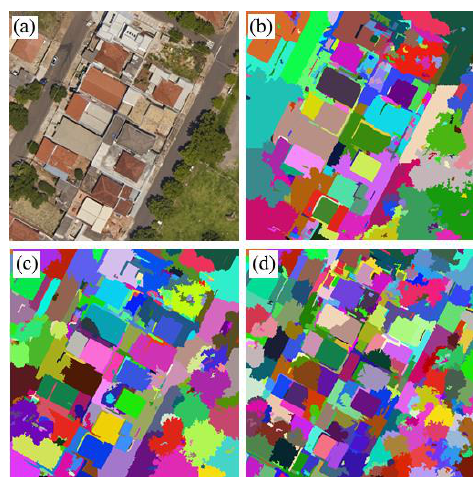
Figure 4 - Multi-scale SLIC approach. (a) Original image, SLIC superpixels with (b) k =50 (c) k =80 and (d) k